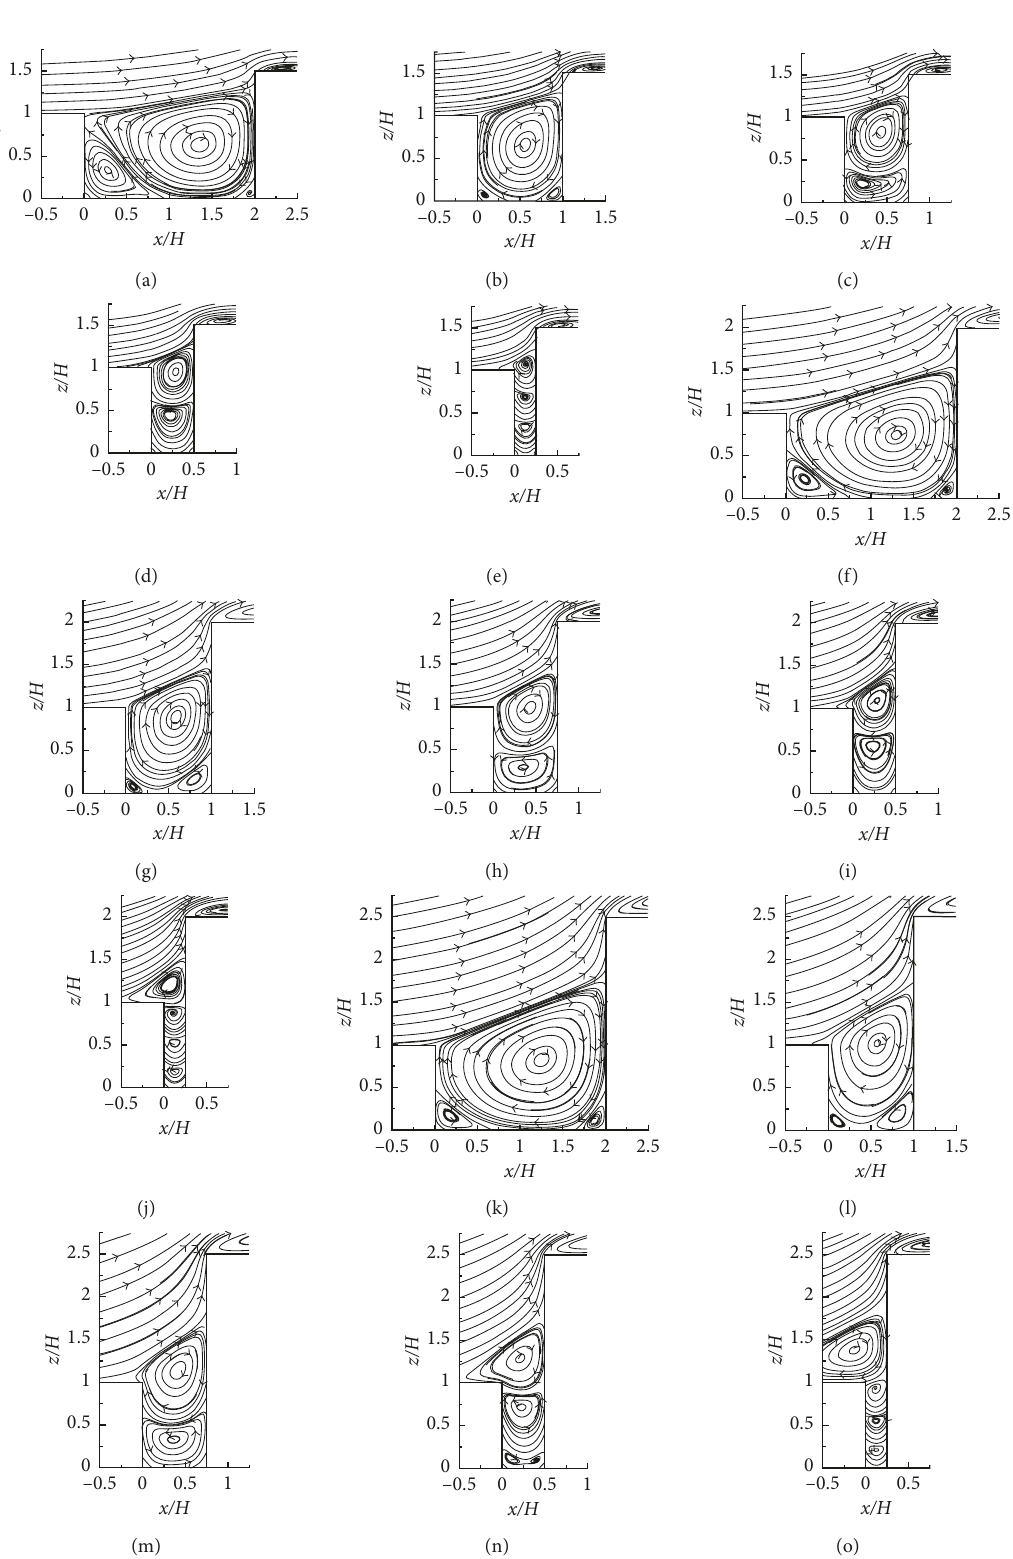
0.5 with H 2 / H 1 (cid:31) 1.33 with H 2 / H 1 (cid:31) 4 with H 2 / H 1 (cid:31)